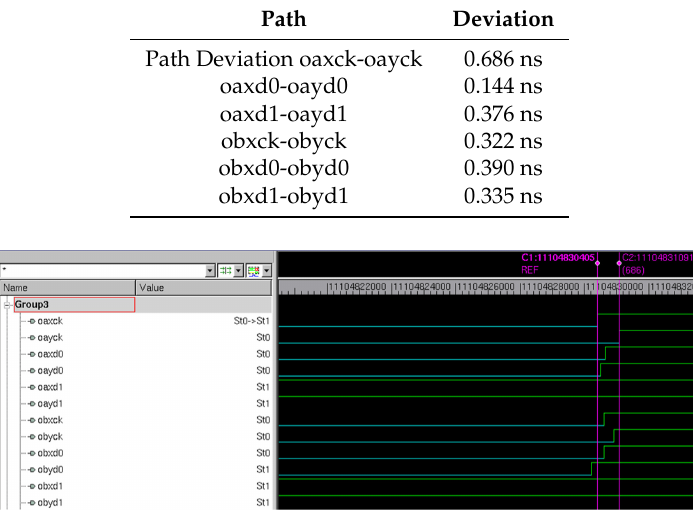
Figure 6. Symmetry between the output bus signals of the two bus interface units